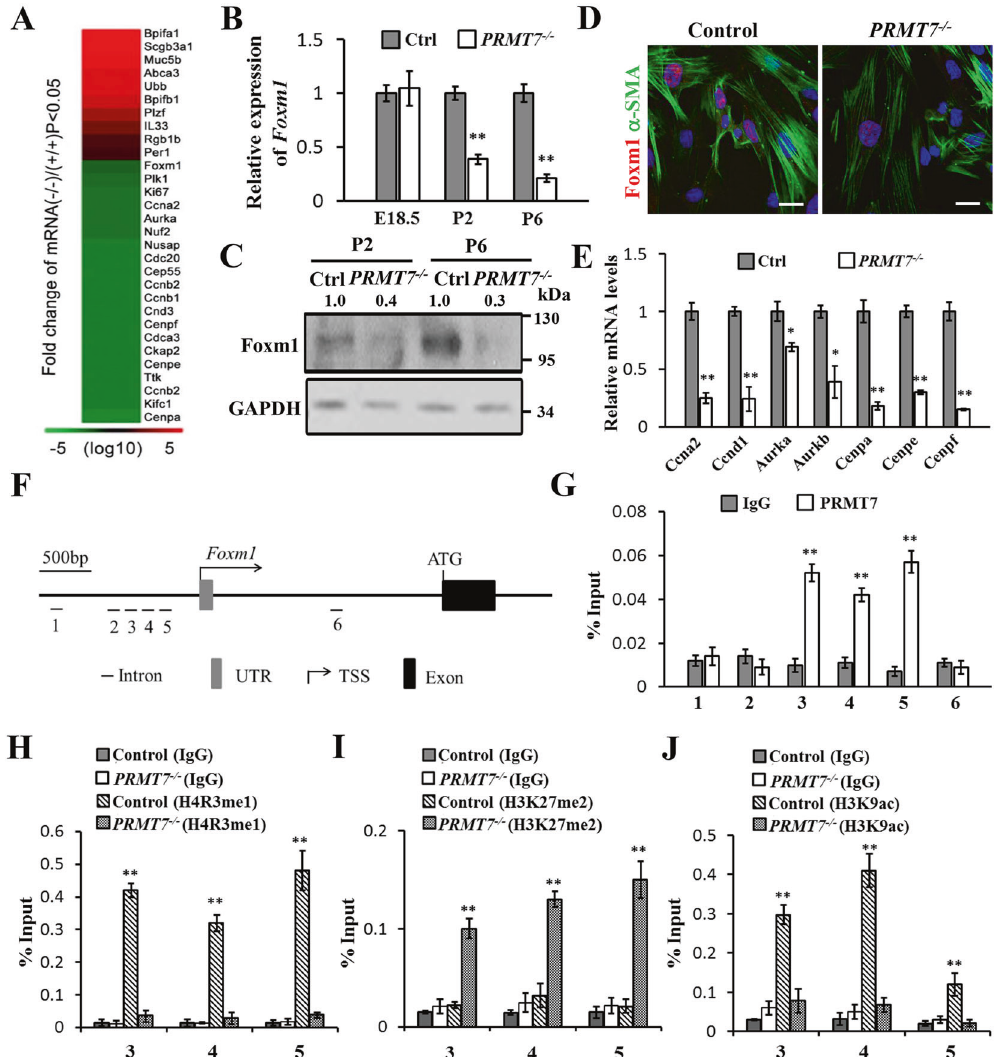
Fig. 5 Epigenetic activating of Foxm1 by PRMT7. A RNA-sequencing analysis showing representative genes that were differentially expressed between PRMT7 − / − and control lung tissues. Red, upregulated genes; green, downregulated genes. B qRT-PCR analysis to validate the expression of Foxm1 in PRMT7 − / − and control lung tissues at E18.5, P2, and P6. Gene expression levels were normalized to β -actin. Data were presented as mean ± SD. n = 5 biological replicates, ** P < 0.01 (Student ’ s t -test). C Western blot analysis showing the decreased Foxm1 expression in PRMT7 − / − lungs at P2 and P6; the relative Foxm1 levels are listed above. GAPDH was used as a loading control. The experiment was repeated three times with similar results. D Representative immunostaining images showing the decreased Foxm1 expression in isolated PRMT7 − / − MYFs. Scale bars: 20 μ m. E qRT-PCR validation of expression for levels of Foxm1 downstream genes. Gene expression levels were normalized to β -actin. Data were presented as mean ± SD. n = 6 biological replicates, * P < 0.05, ** P < 0.01 (Student ’ s t -test). F Schematic diagrams of the mouse Foxm1 gene structure, with bars representing the regions examined by ChIP, white boxes represent exons; black lines represent introns. G – J ChIP assay performed with anti-PRMT7 ( G ), anti-H4R3me1 ( H ), anti-H3K27me2 ( I ), and anti-H3K9ac ( J ) antibodies, at indicated regions of the Foxm1 gene locus in control and PRMT7 − / − lung tissues at P2, n = 5 animals for each group. All changes were normalized to inputs. The data shown are the mean ± SEM of three independent experiments. ** P < 0.01 (Student ’ s t